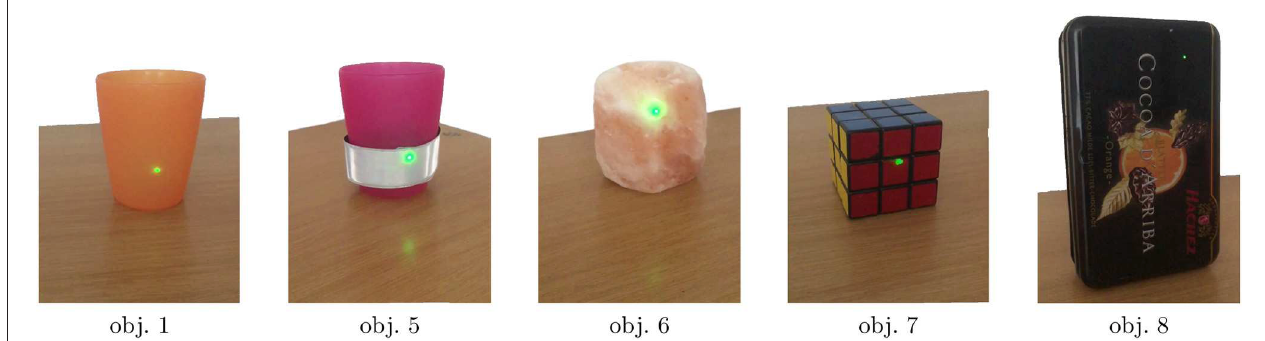
FIGURE 2 | Close-up photos of candidate objects during highlighting in our experiments. The differing optical properties cause dissimilar appearances (using identical laser pointer illumination). Object 1 is a representative of the homogeneous objects (see Figure 1 for all objects), for which the highlighting appears similar. Objects 5 to 8 correspond to the heterogeneous objects. Note the reflection on the table surface for objects 5 and 6, and the low salience of the laser point at the top right of object 8.